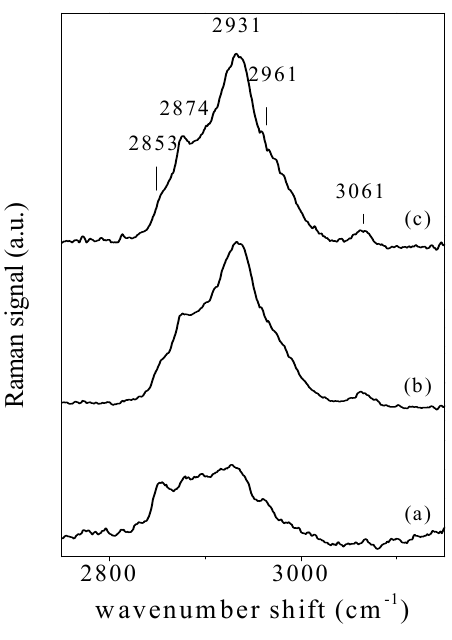
Figure 6. Raman spectra of oral tissue biopsies from PV affected patients (a) , patients under drug therapy (b) and patients in the remission stage of illness (recovered) (c) in the wavenumber range 2,700–3,200 cm − 1